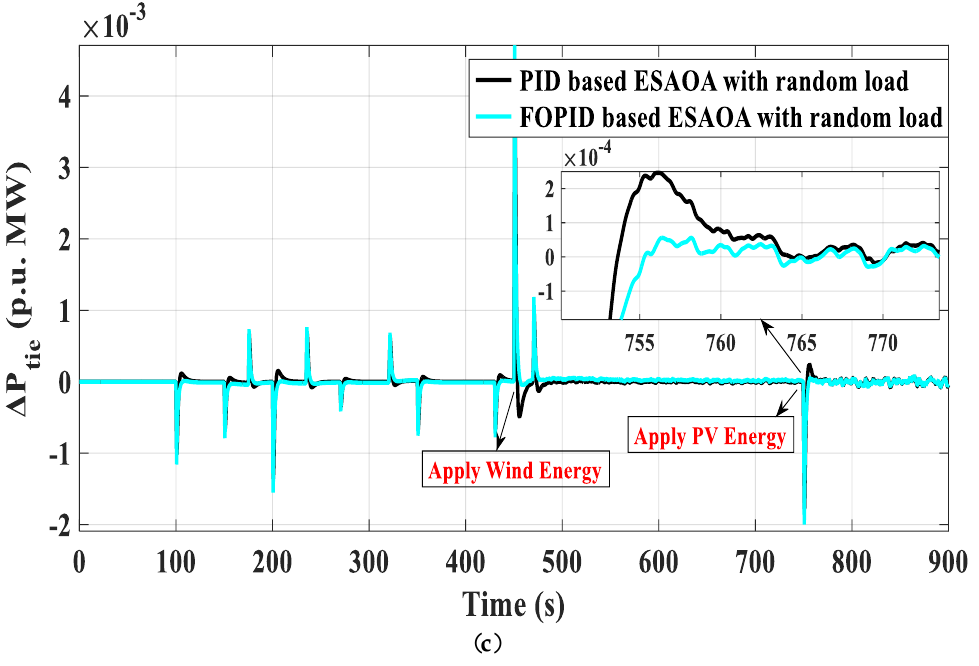
Figure 21. Dynamic system response of scenario B with random load variation at area-1, wind energy at t = 450 s at area-1, and PV at t = 750 s at area-2 ( a ) ∆ f 1 , ( b ) ∆ f 2 , and ( c ) ∆ p tie .